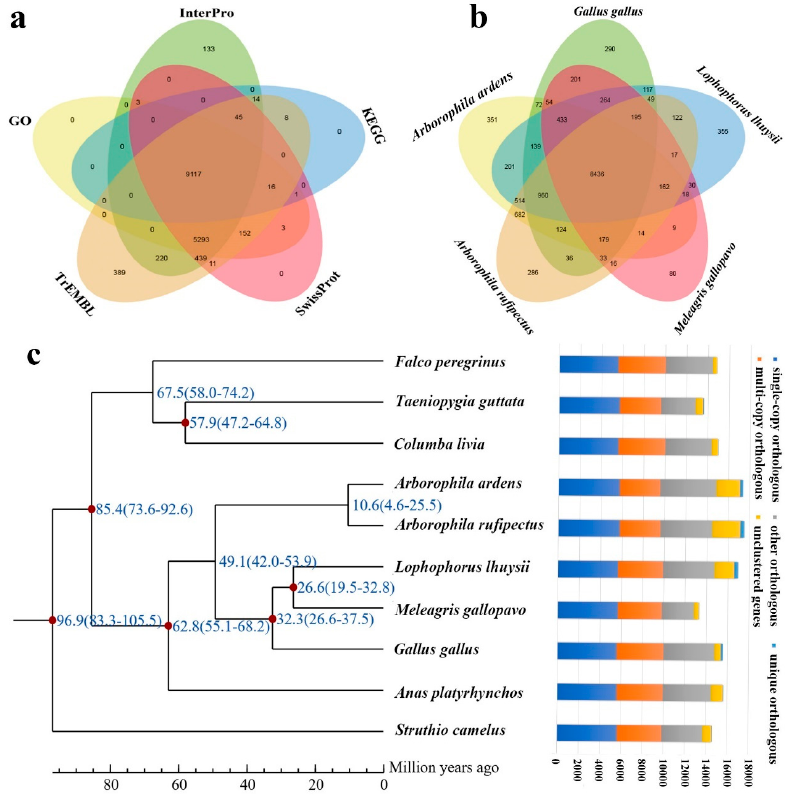
Figure 3. Comparative genomics in avian species studied. ( a ) Functional annotation of Sichuan partridge genes. ( b ) Orthologous gene clusters in five Phasianidae species. ( c ) Phylogenetic tree constructed using 1:1 orthologous genes. The time lines indicate divergence times among the